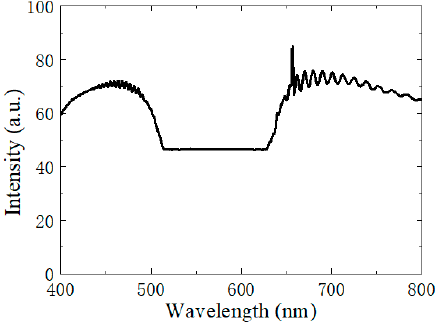
Figure 5. Transmittance spectrum of the RHCLC film.